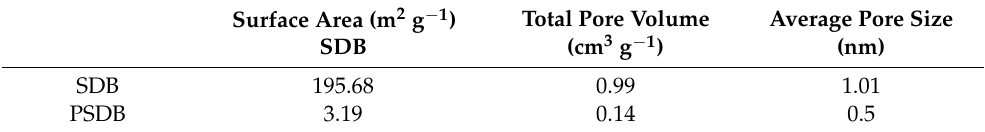
Table 1. BET analysis of SDB and